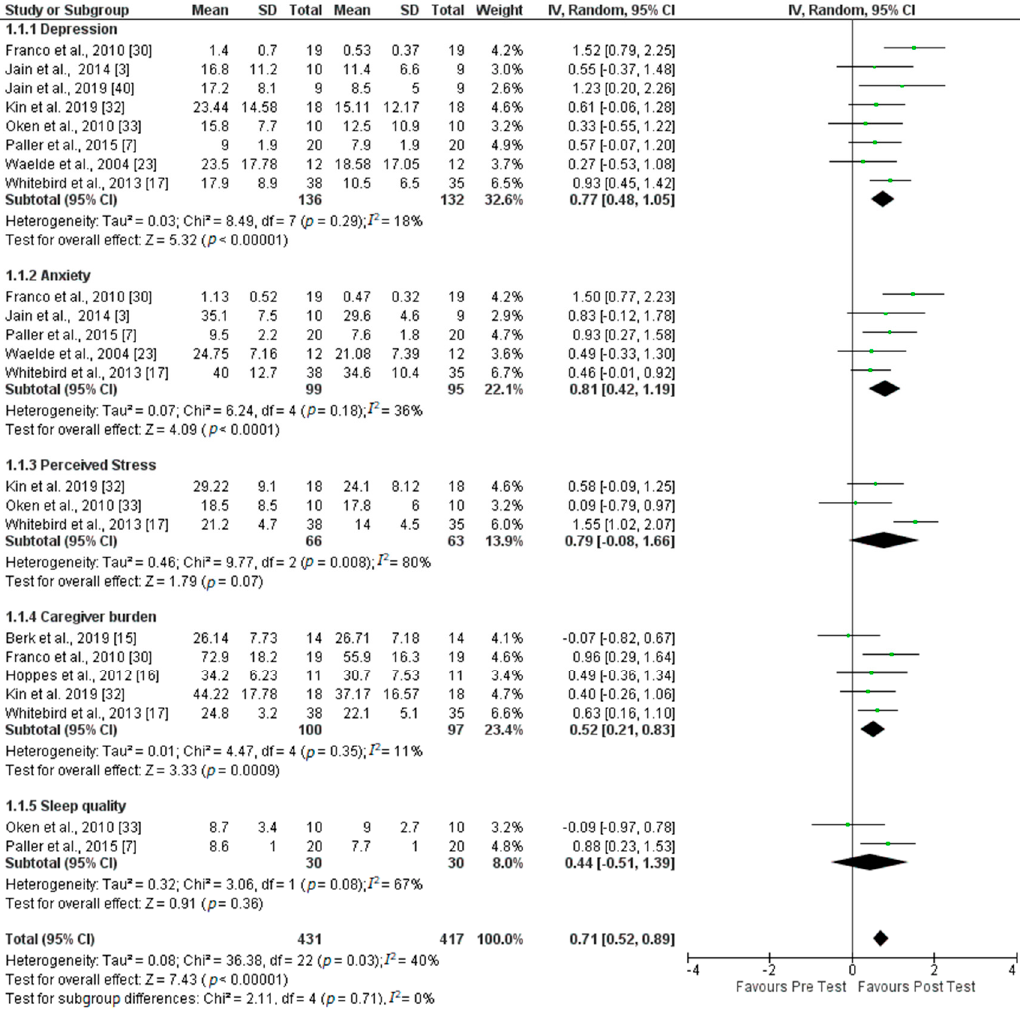
Figure 2. Forest plot of the effect size of mindfulness intervention on psychological variables Note: Tau² = estimate of variance of effect sizes; Chi² = existence of heterogeneity; df = global effect size indicator on the results of a meta ‐ analysis; p = statistically significant heterogeneity; green dots = effect size of each study; black diamond in each variable = effect size of the set of studies; final black diamond = size of subgroup effect.